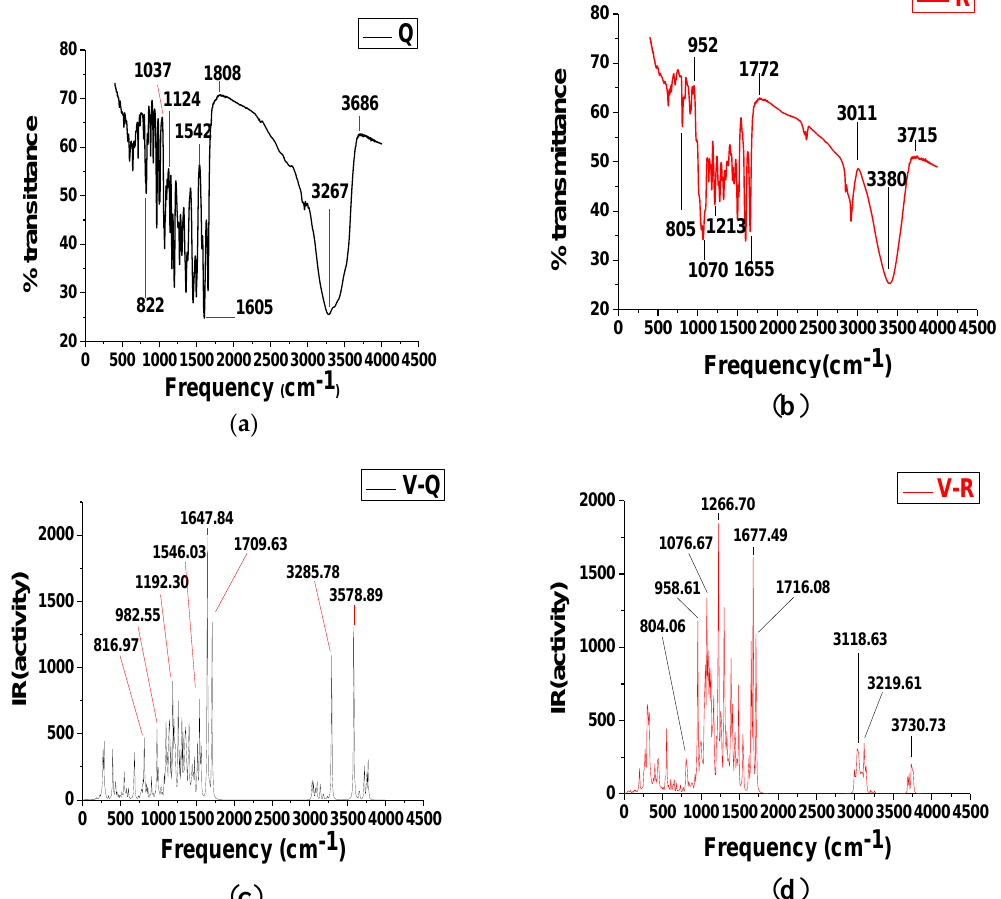
Figure 2. The experimental Fourier transforms infrared (FT-IR) spectrums of Q and R shown in ( a , b ); The theoretical FT-IR spectrums of V-Q and V-R shown in ( c , d ).